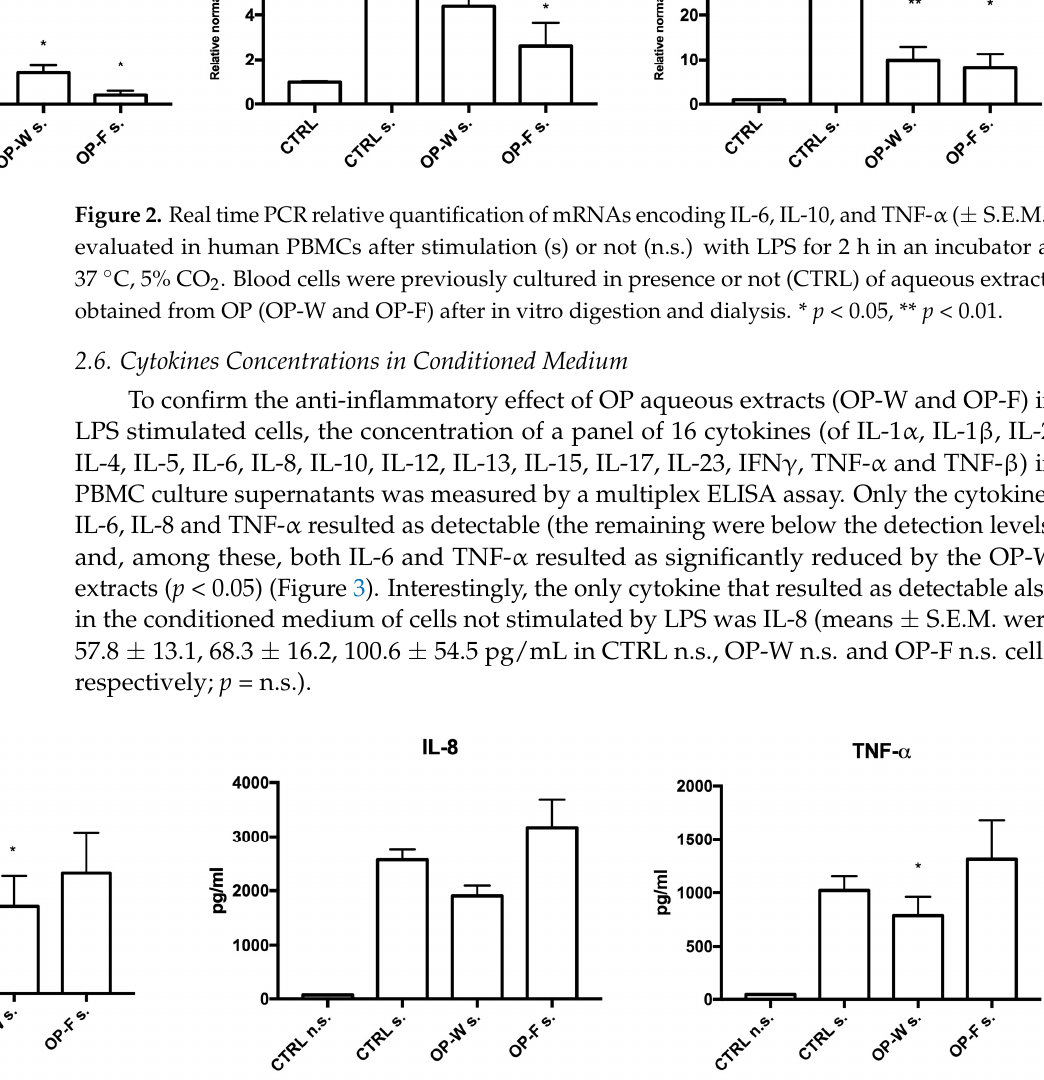
Figure 3. Cytokine concentrations evaluated in the culture medium of human PBMCs after stimula- tion (s), or not (n.s.), with LPS for 2 h in an incubator at 37 ◦ C, 5% CO 2 . Blood cells were previously cultured in presence, or not (CTRL), of aqueous extracts obtained from OP after in vitro digestion and dialysis. * p < 0.05.